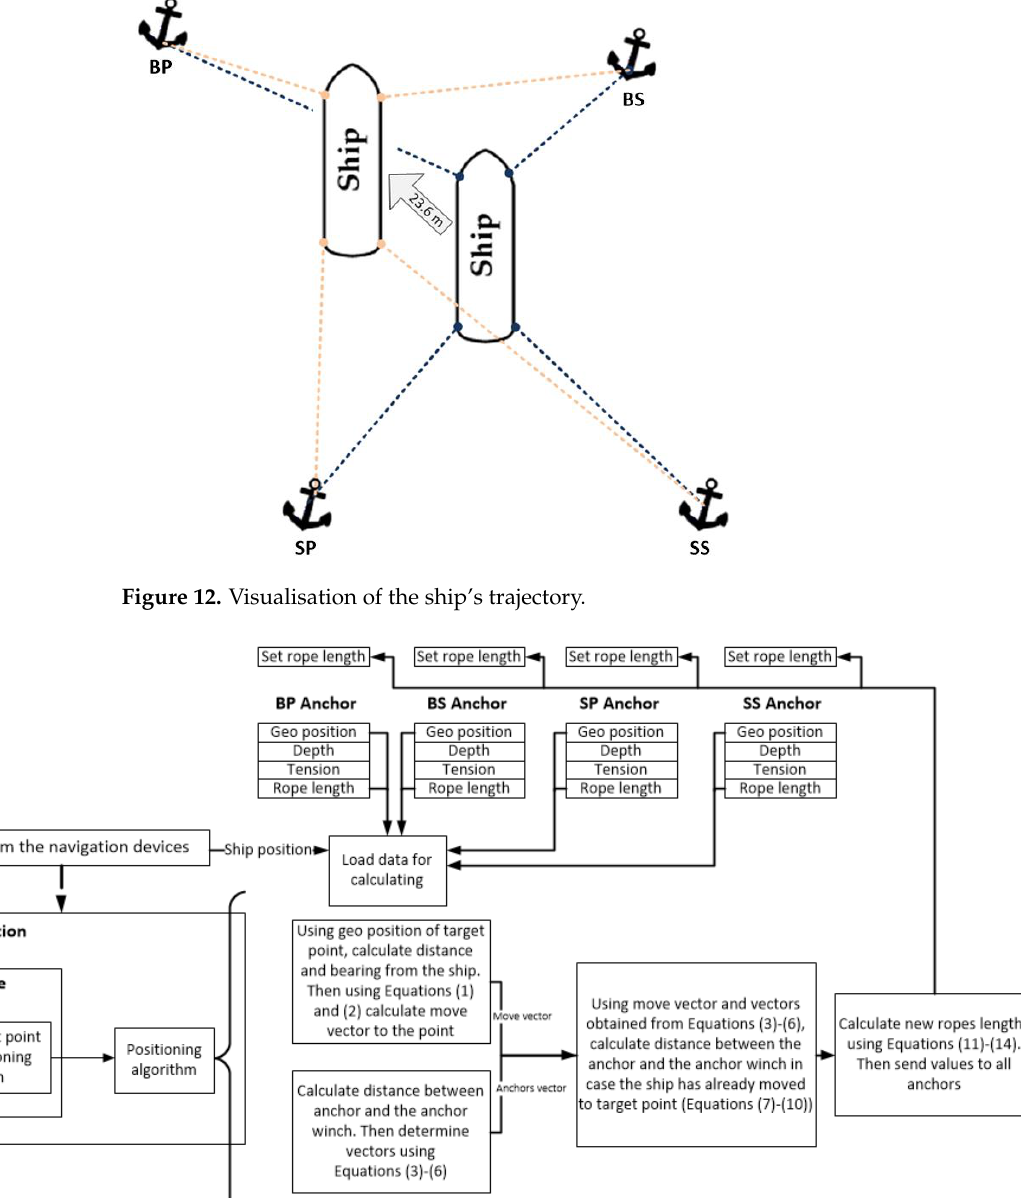
Figure 13. Information flow in the positioning system.